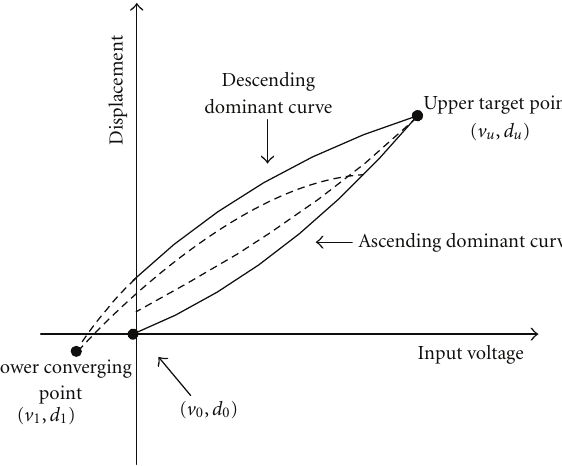
Figure 1: Ascending and descending dominant